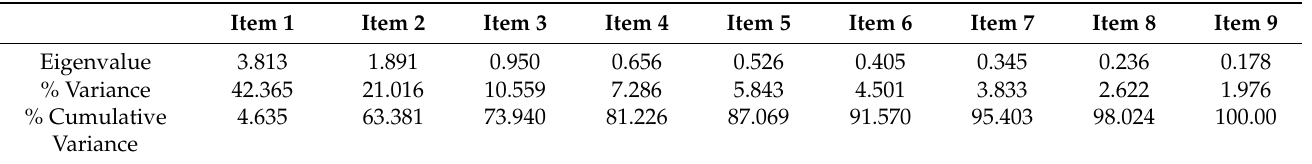
Table 3. Percentages of variance explained by the common factors obtained in the factor analysis of polychoric